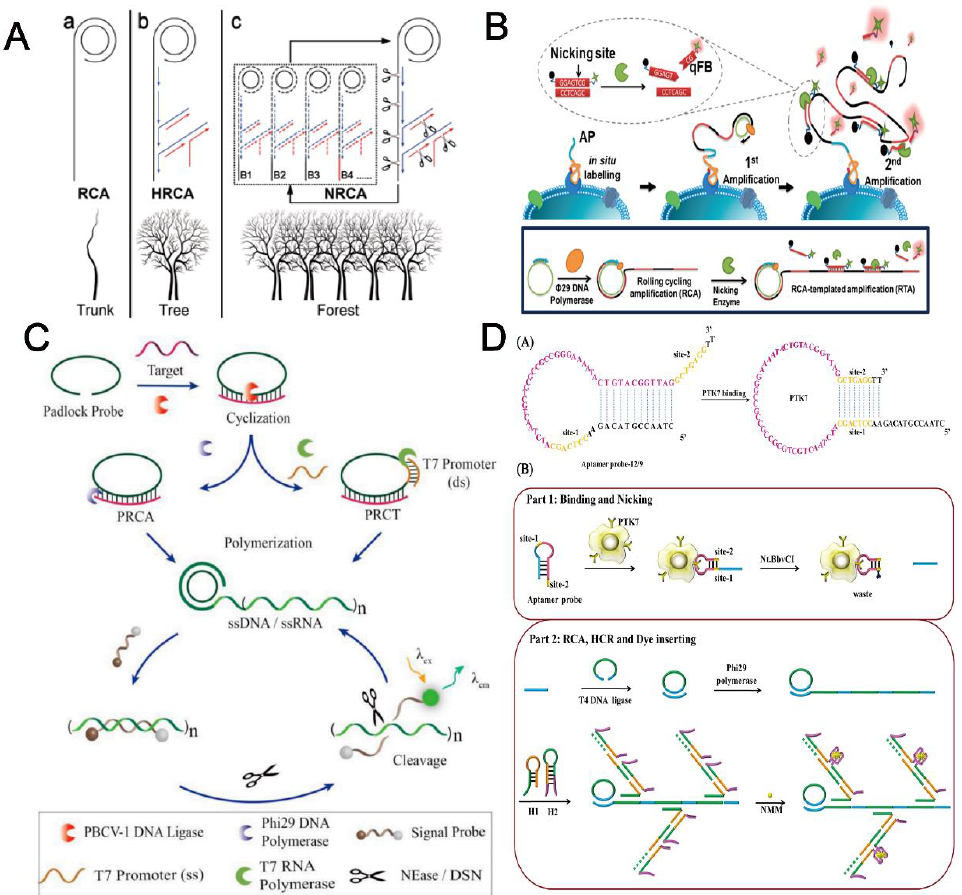
Figure 4. ( A ) Basic principle of nicking enzyme combined with RCA. (Reproduced with permission [74]. Copyright 2015. Royal Society of Chemistry.) RCA and nicking enzyme act together for ( B ) cancer cell phenotypic analysis. (Reprinted with permission from Ref. [75]. Copyright 2017 American Chemical Society.) ( C ) The detection of DNA or RNA. (Reprinted with permission from Ref. [76]. Copyright 2020 Elsevier.) ( D ) The analysis of living cell surface membrane proteins. (Reprinted with permission from Ref [77]. Copyright 2018 Elsevier.)